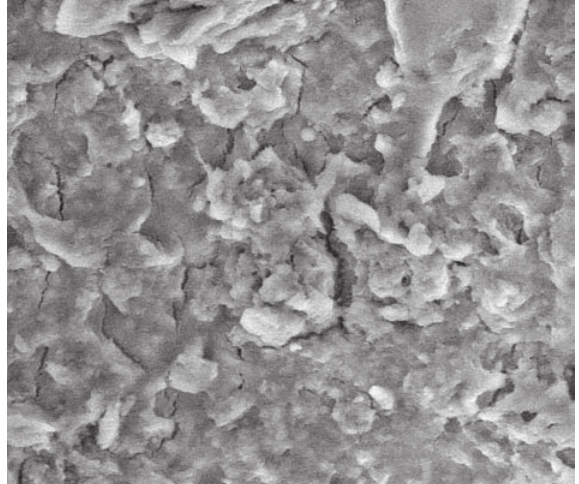
Figure 6- Scanning Electron Microscopy (SEM) micrograph of the smear layer in root canals irrigated with NaOCl. No dentinal tubules are visible because of the smear layer covering the root canal